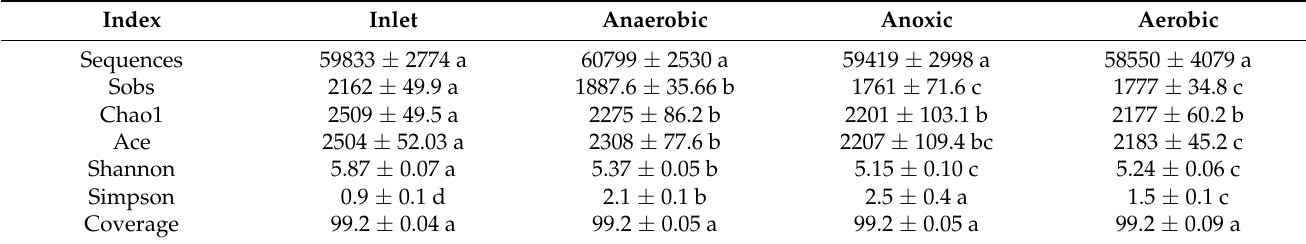
Table 2. Richness and diversity indices of microbial communities for sludge